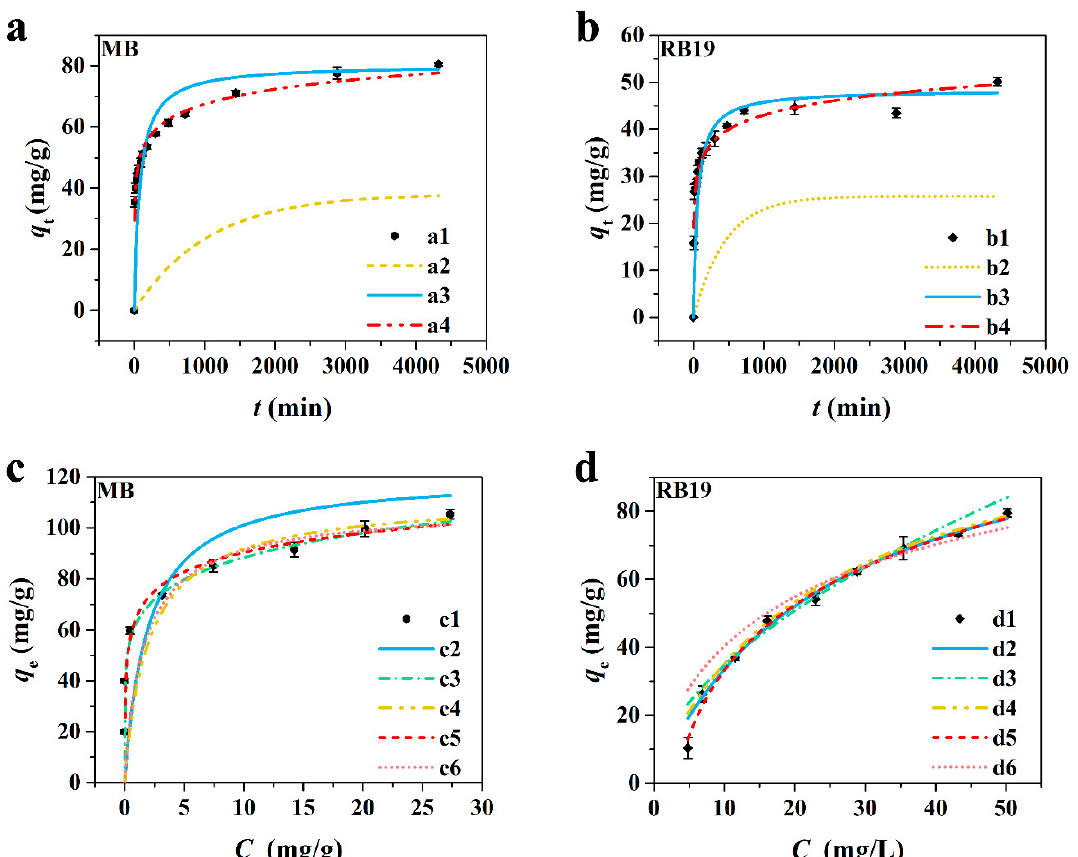
Figure 5. Kinetic plots for ( a ) MB and ( b ) RB19 adsorption: (a1, b1) Experimental data, (a2, b2) pseudo-first order kinetic model, (a3, b3) pseudo-second order kinetic model and (a4, b4) Elovich kinetic model. Isotherm models for ( c ) MB and ( d ) RB19 adsorption: (c1, d1) Experimental data, (c2, d2) Langmuir isothermal model, (c3, d3) Freundlich isothermal model, (c4, d4) Langmuir-Freundlich